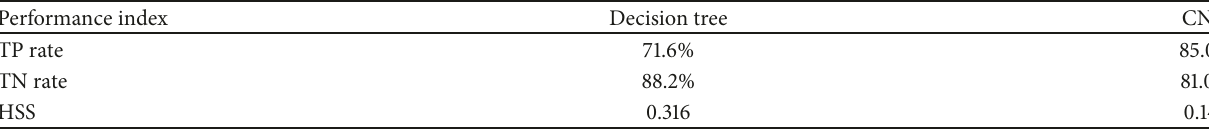
Table 6: Performance